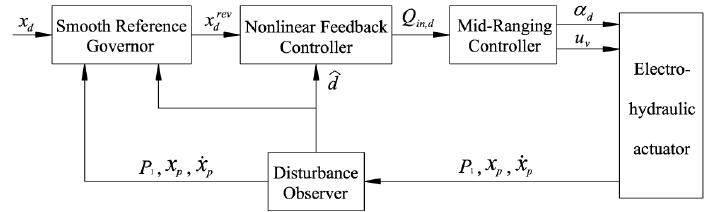
Figure 4. Block diagram of the controller structure.